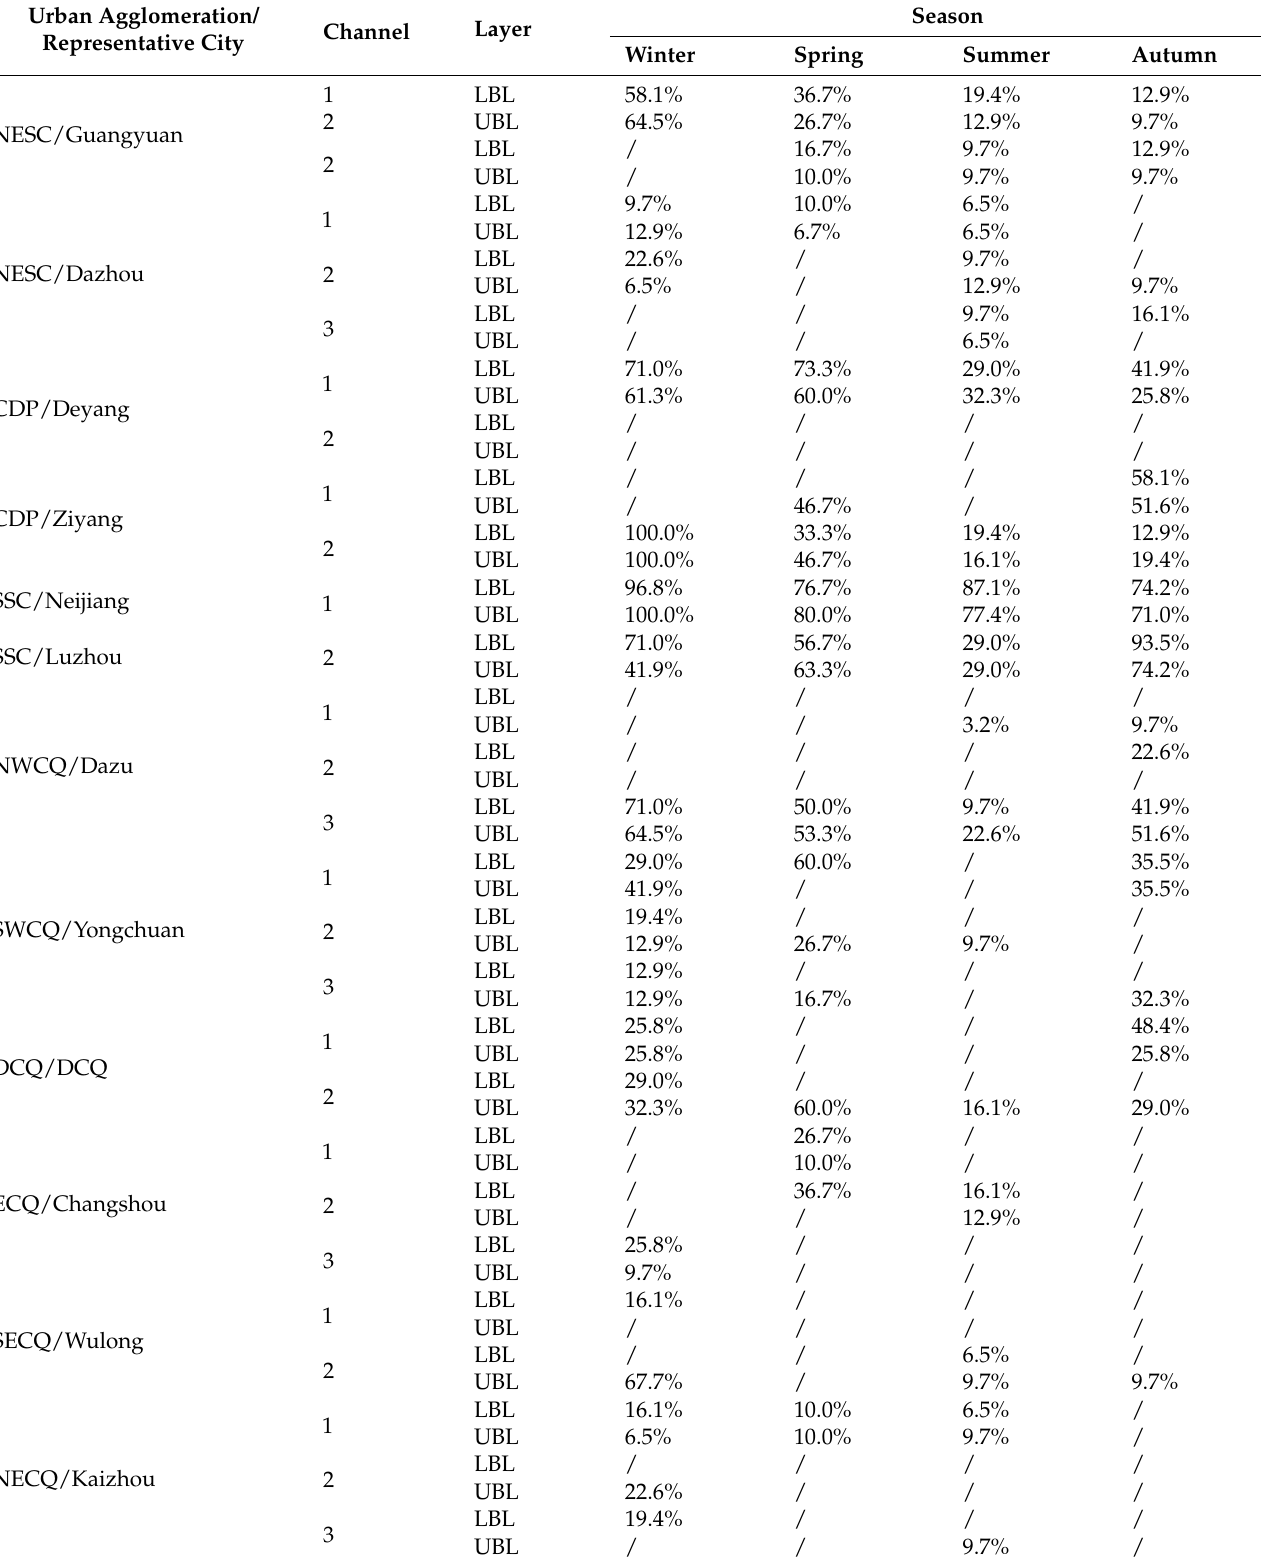
Table 2. The occurrence frequencies of transport channels affecting the receptor cities originating in representative cities of each urban